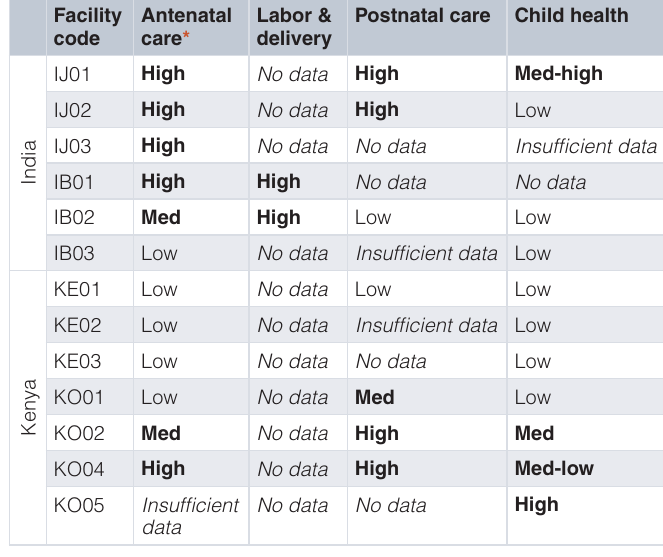
Table 2. Levels of FP integration into different services areas by facility and country. KO03 and KO06 excluded because insufficient data for all units. Text indicates where on broad range of level of integration (30–100%). If there are two notations, it indicates differences in client flow and client survey data, where at least 5 clients were surveyed about that service area. Bold text indicates well-integrated care, non-bold indicates poorly integrated